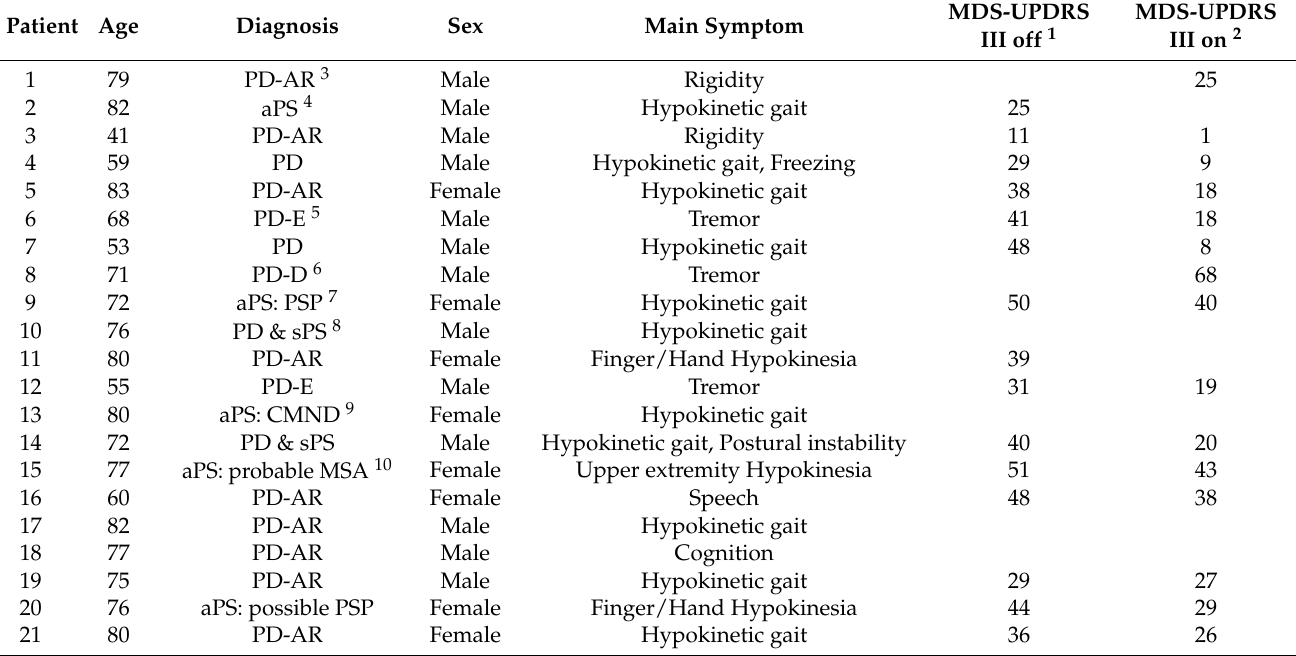
Table 1. This table summarizes various baseline characteristics for all consecutive patients with Parkinson Syndromes that received the stimulation